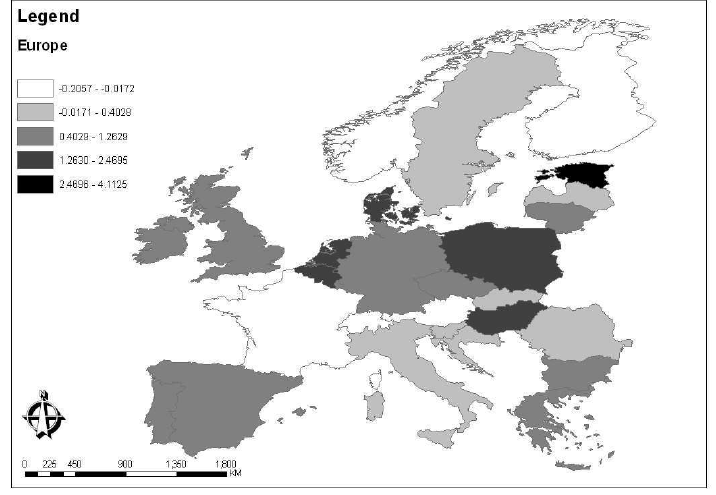
Figure 2 – Quantile maps of the 28 European countries: spatial distribution of ln (cid:16) ˜ y ( s i ,2010 )